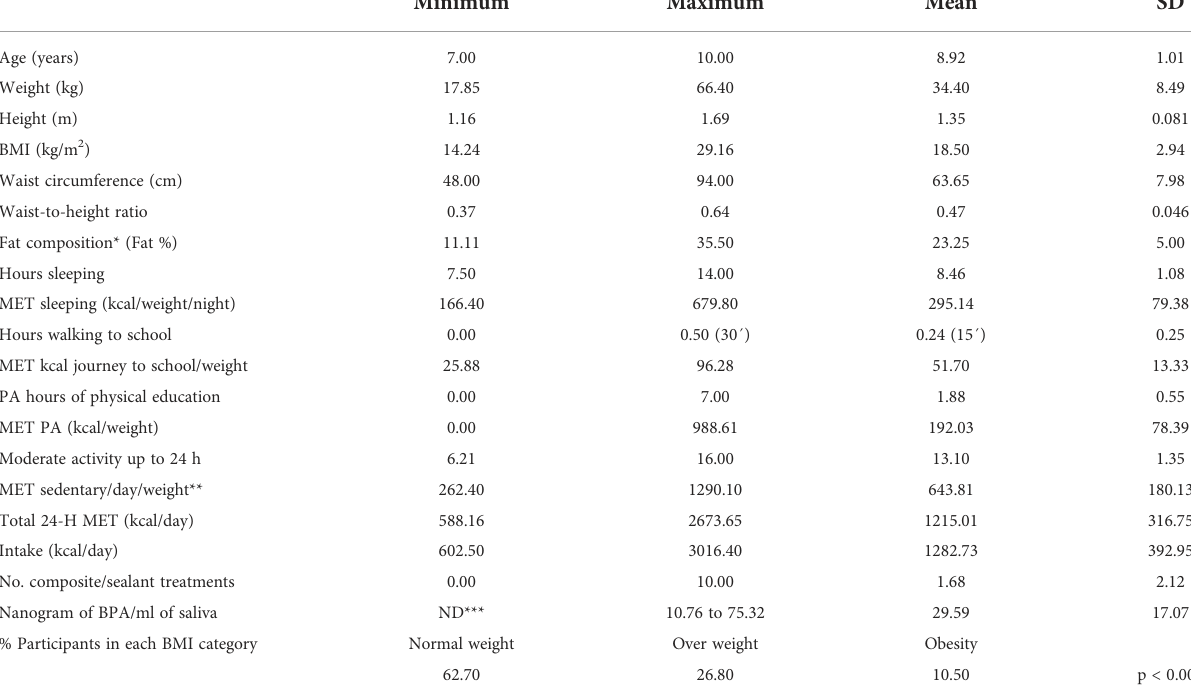
TABLE 2 Population characteristics (n =